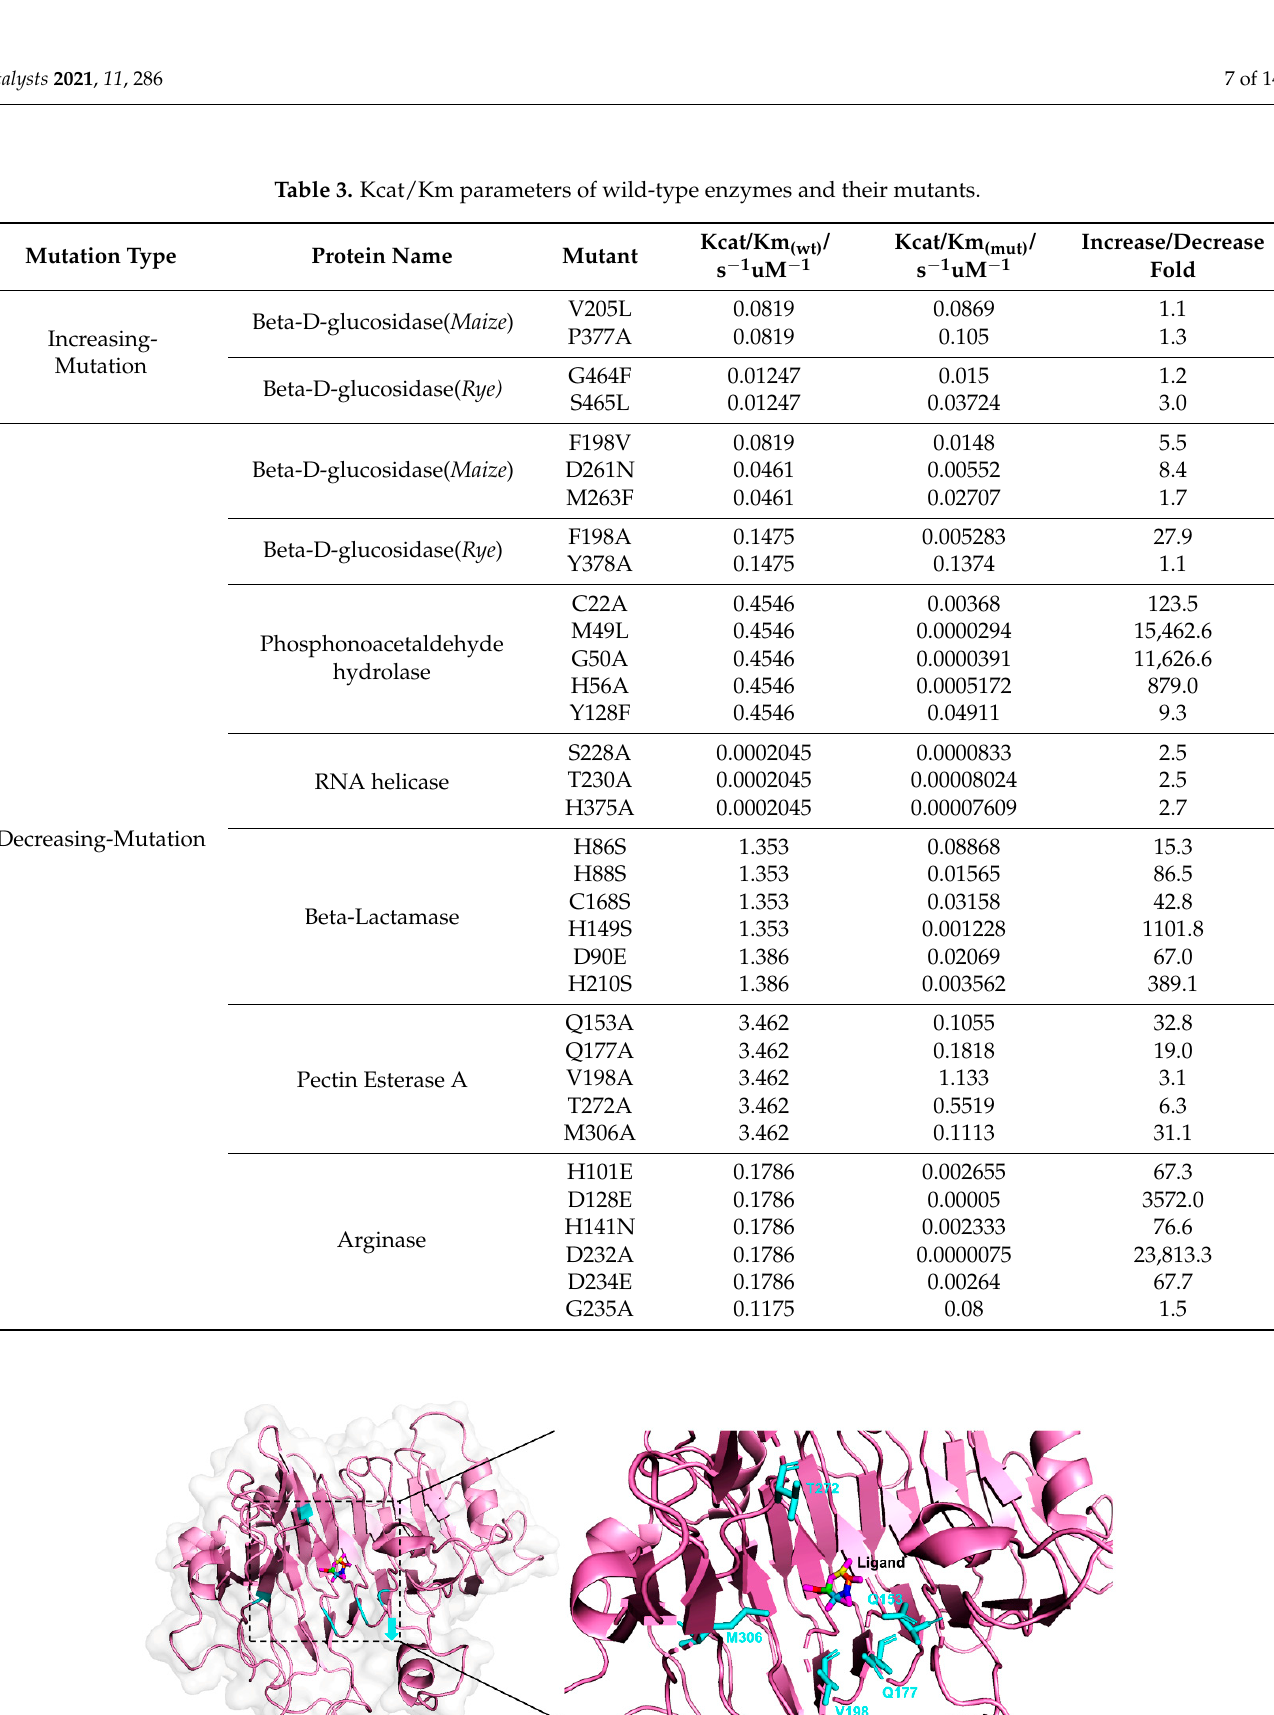
Figure 7. View of predicting effects of residue mutation on the catalytic efficiency of the amino acid hydrolysis reaction (Arginase, PDB:1RLA). Regions of mutated sites that decrease catalytic efficiency are highlighted in cyan on the cartoon. Ligand is shown as sticks in the rainbow. 3. Discussion Research on the engineering of hydrolases has always been the hotspot in enzyme engineering. In this paper, we exhibited a computational approach to predict the change of catalytic efficiency of hydrolases after residue mutations. Importantly, the dataset employed in this method was a manually curated, literature-derived dataset, comprising 314 single residue mutations, and associated for the first-time experimental information on alterations in catalytic hydrolysis reaction activity with three-dimensional structures of protein–ligand complexes. Nevertheless, there are still some unanswered questions. As the data (Supplementary File) show, we only focused on individual residue muta- tions of enzymes, whereas iterative mutations are more integrant in protein engineering. Previous studies assumed that mutation effects of proteins have additivity [58,59], and the ProSAR algorithm [60] was also applied to identify synergistic effects by statistical analysis way. Therefore, it is still a rough but worthwhile road to study the effects of it-